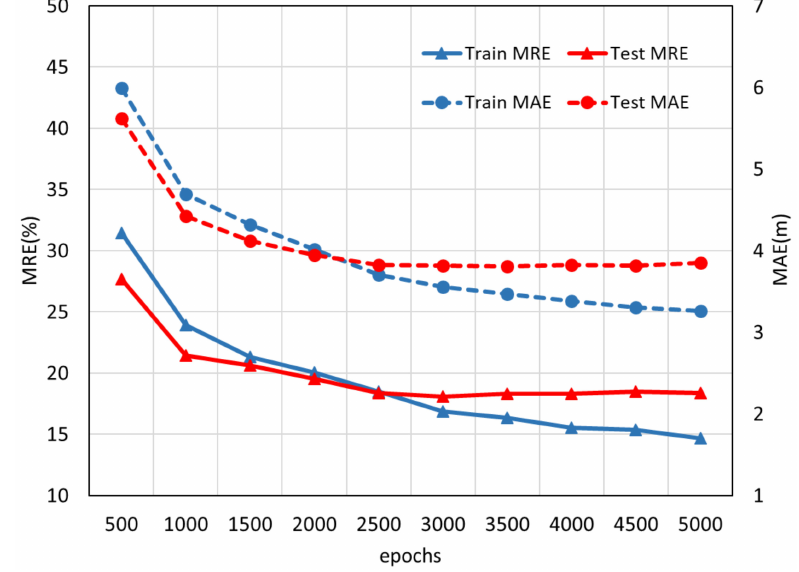
Figure 12. Change trend of MRE and